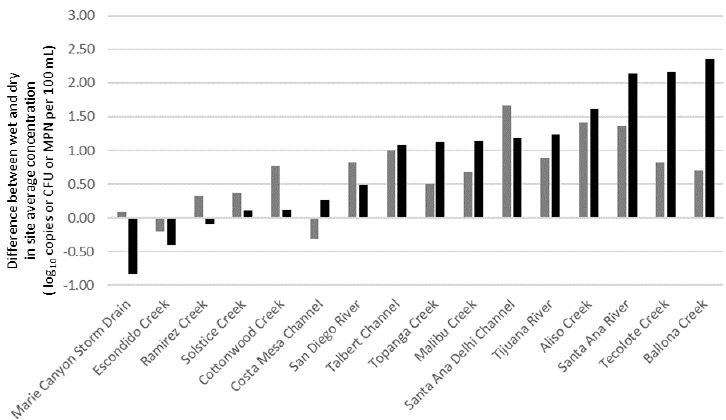
Figure A2. Site average concentration (in log 10 unit) in wet weather subtracted by that in dry weather for HF183 (black bars) and for enterococci (gray bars). The HF183 site average concentration was calculated by the Poisson approach as described above in the Appendix section. The enterococci site average concentration was calculated directly as the geomean. Sites are sorted from left to right by wet vs. dry differences in site average HF183 concentrations.